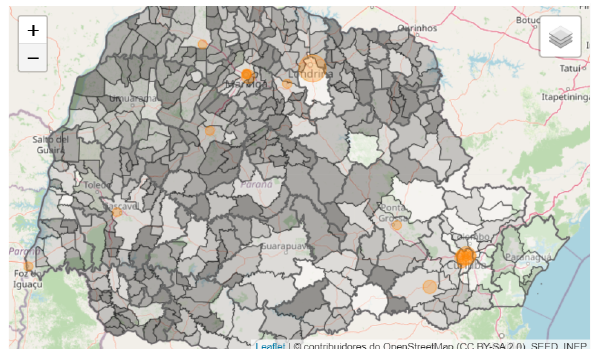
Figure 4 . Percentage of graduate teachers aggregated with municipalities of Paraná, and the proportional punctual symbols represent the number of vacancies in the high educational